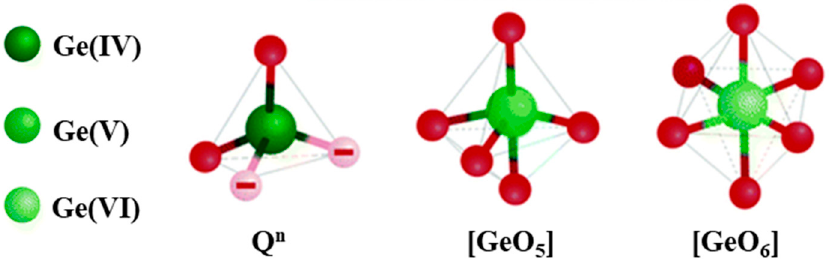
Figure 3. Schematic of the structural units in germanate glasses, modified from [46].